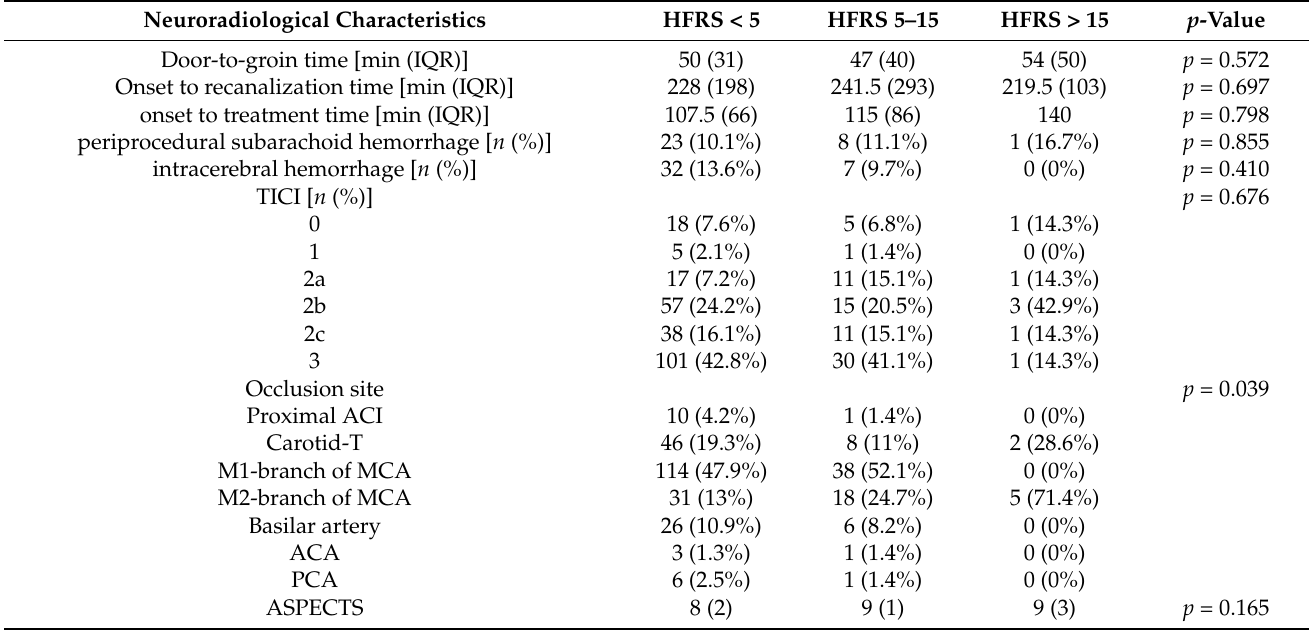
Table 4. Neuroradiological characteristics of the different frailty groups. Neuroradiological